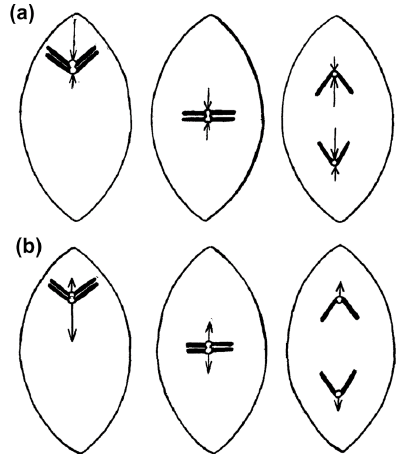
Figure 1. First models of chromosome congression involving either pushing or pulling forces on chromosomes. ( a ) Model of chromosome congression proposed by Darlington [1] involving a balance of pushing forces on chromosomes. These forces are higher when chromosomes are closer to spindle poles; ( b ) Model of chromosome congression proposed by Östergren involving pulling forces on chromosomes that are proportional to k-fiber length. Adapted from Östergren, 1950 [13] and displayed under a Creative Commons Attribution-Noncommercial-Share Alike 4.0 International license, as described at https://creativecommons.org/licenses/by-nc-sa/4.0/legalcode.